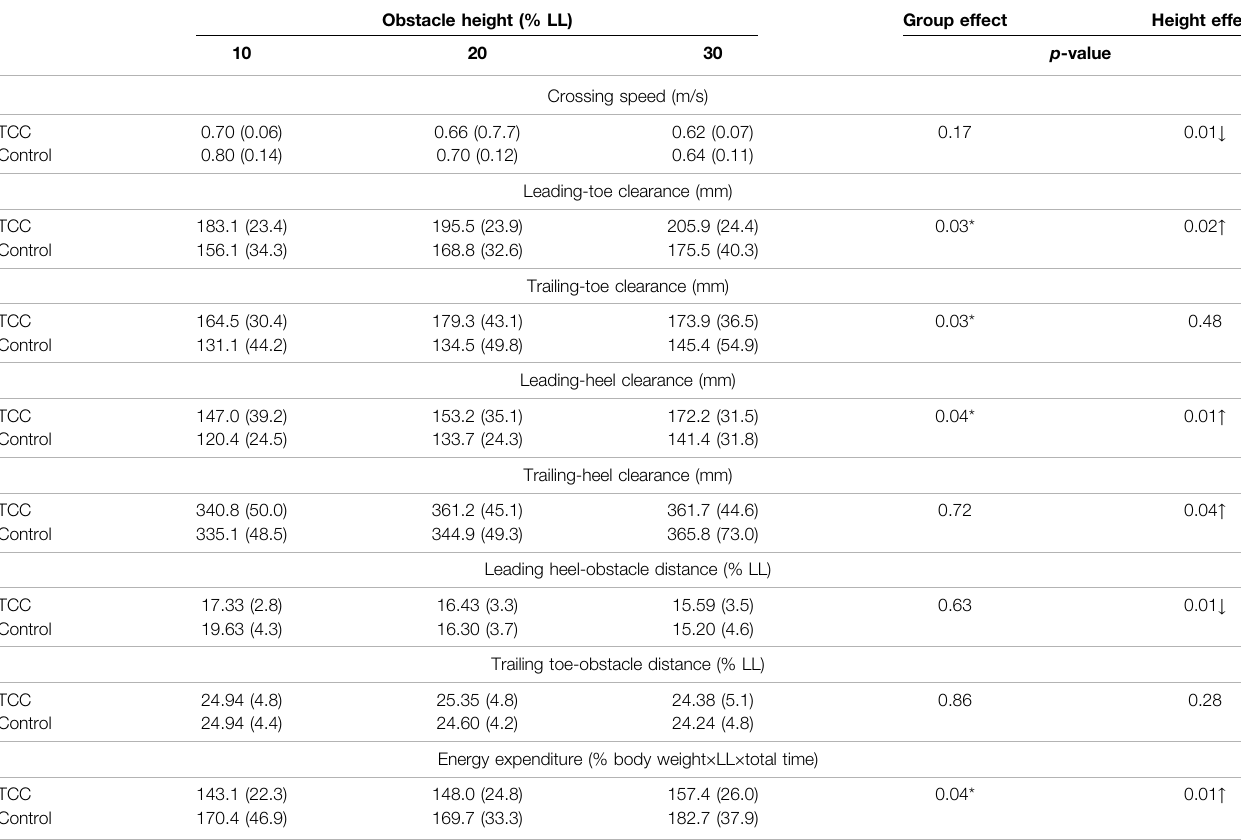
TABLE 1 | Means (standard deviations) of the end-point variables for the TCC and Control groups when crossing obstacles of three different heights. Obstacle height (%